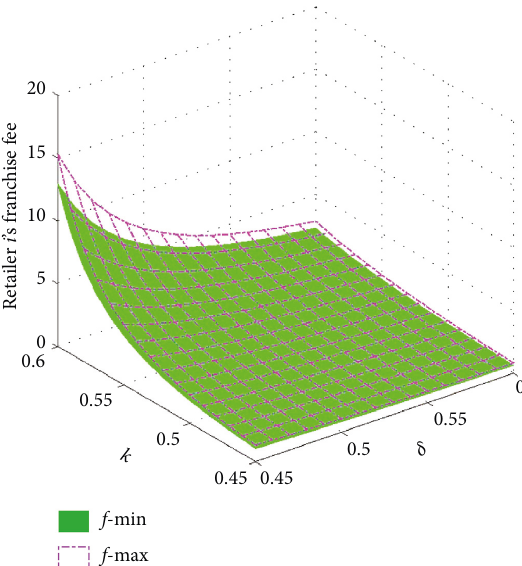
Figure 11: Feasible lower and upper bounds of franchise fees vs. k and δ in the VB model.